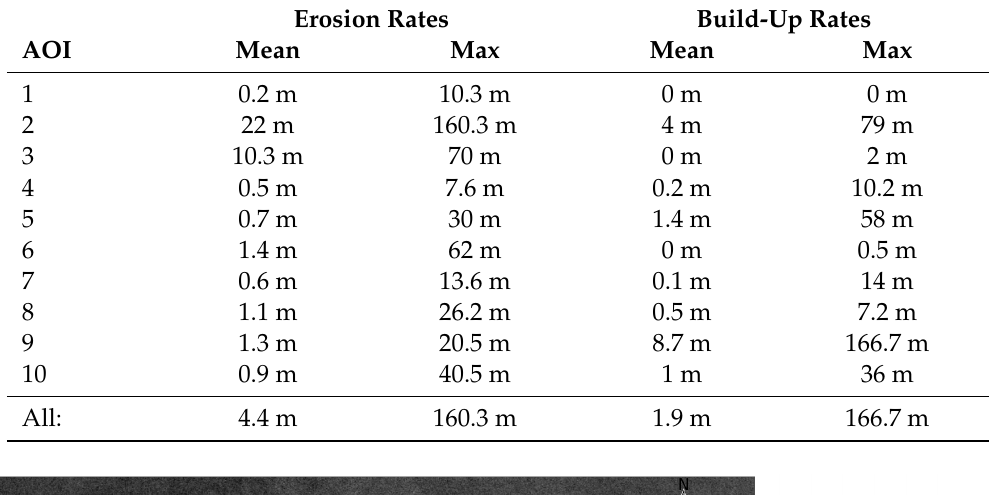
Table 5. Average and maximum rates of erosion and build-up between 2017 and 2020 per aoi. The numbers are based on average values for 200 m segments along the coastline. Strongest erosion rates were observed for Drew Point–Cape Halkett, United States of America (USA) (aoi 02), whereas Bezimyanniy Cape–Eastern Oyagoss Cape in Russia (aoi 09) features highest build-up rates. Erosion Rates Build-Up Rates